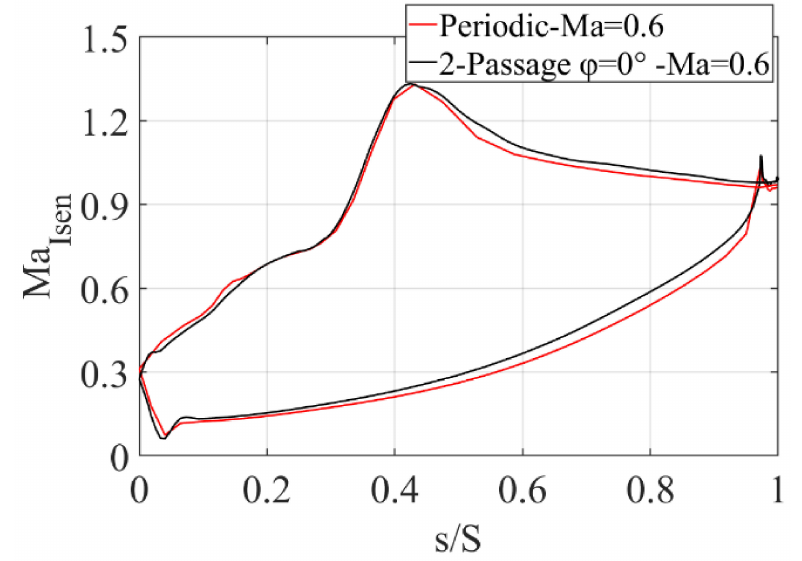
Figure 7. Near tip loading at 97% span of test blade surface with tailboard angle of 0 ◦ at rotating condition (Rotating Mach number =